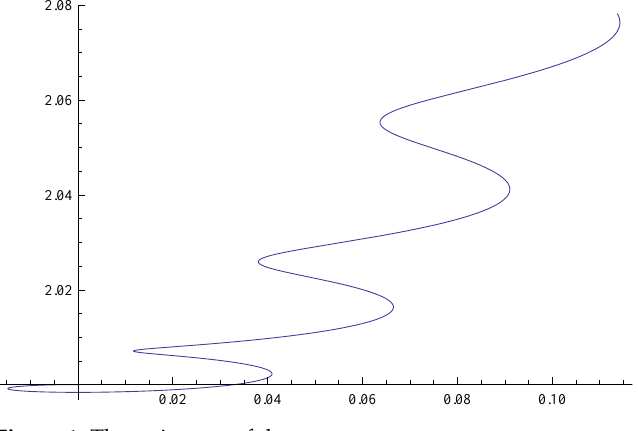
Figure 1. The trajectory of the